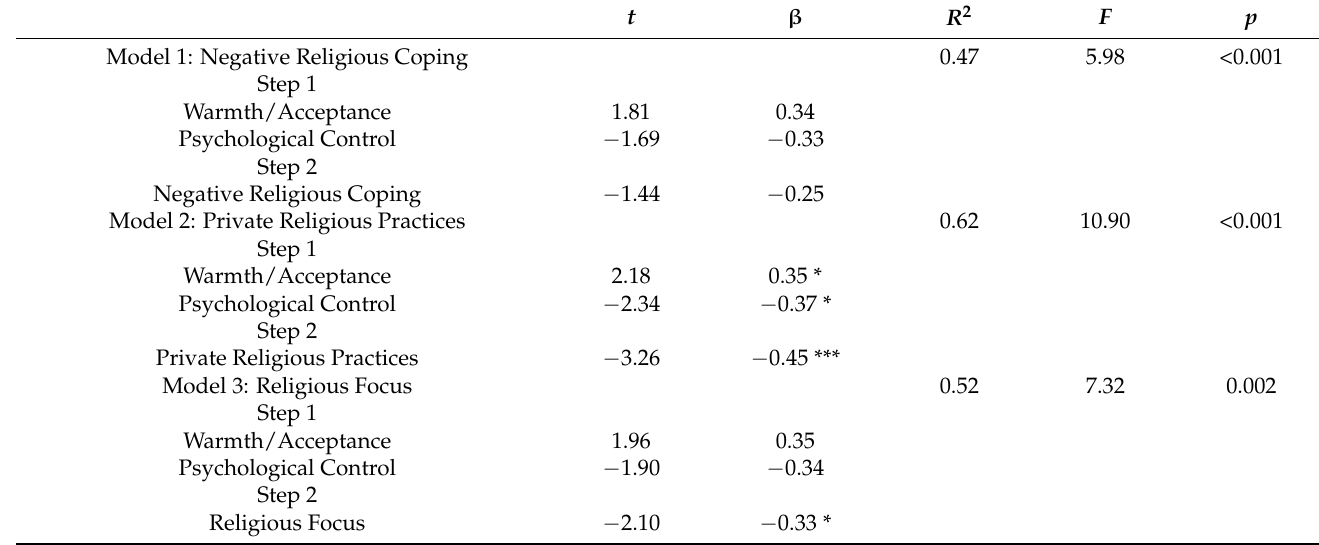
Table 5. Hierarchical linear regressions predicting the frequency of parent–child communication about